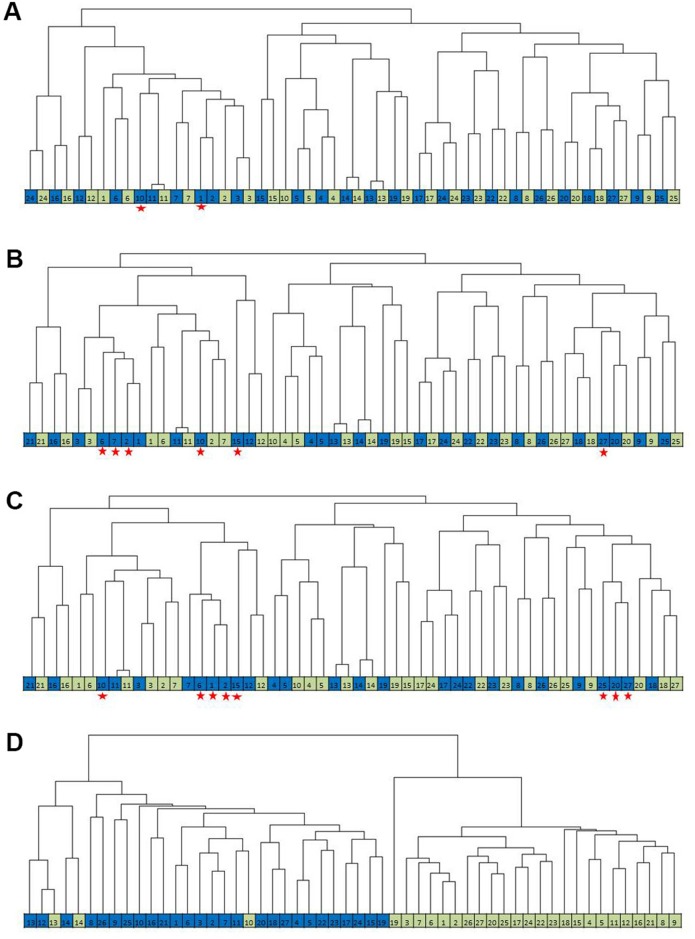
Dendrograms of matched FF and FFPE pairs at the three cut-off values.
(A) Clusters based on 1,432 probes (P<0.01): only 2 FFPE samples did not cluster with their FF counter pairs. (B) Clusters based on 2,530 probes (P<0.05): 6 FFPE samples did not cluster with their FF counter pairs. (C) Clusters based on 3,351 probes (P<0.1): 8 FFPE samples did not cluster with their FF counter pair sample. (D) Clusters based on all the 24,526 profiled probes: the main two arms of the dendrogram are based on the FFPE or FF samples. Each square represents a sample; Blue: FFPE; Green: FF, Red asterix indicates the FFPE samples that did not cluster with their FF counterpart.